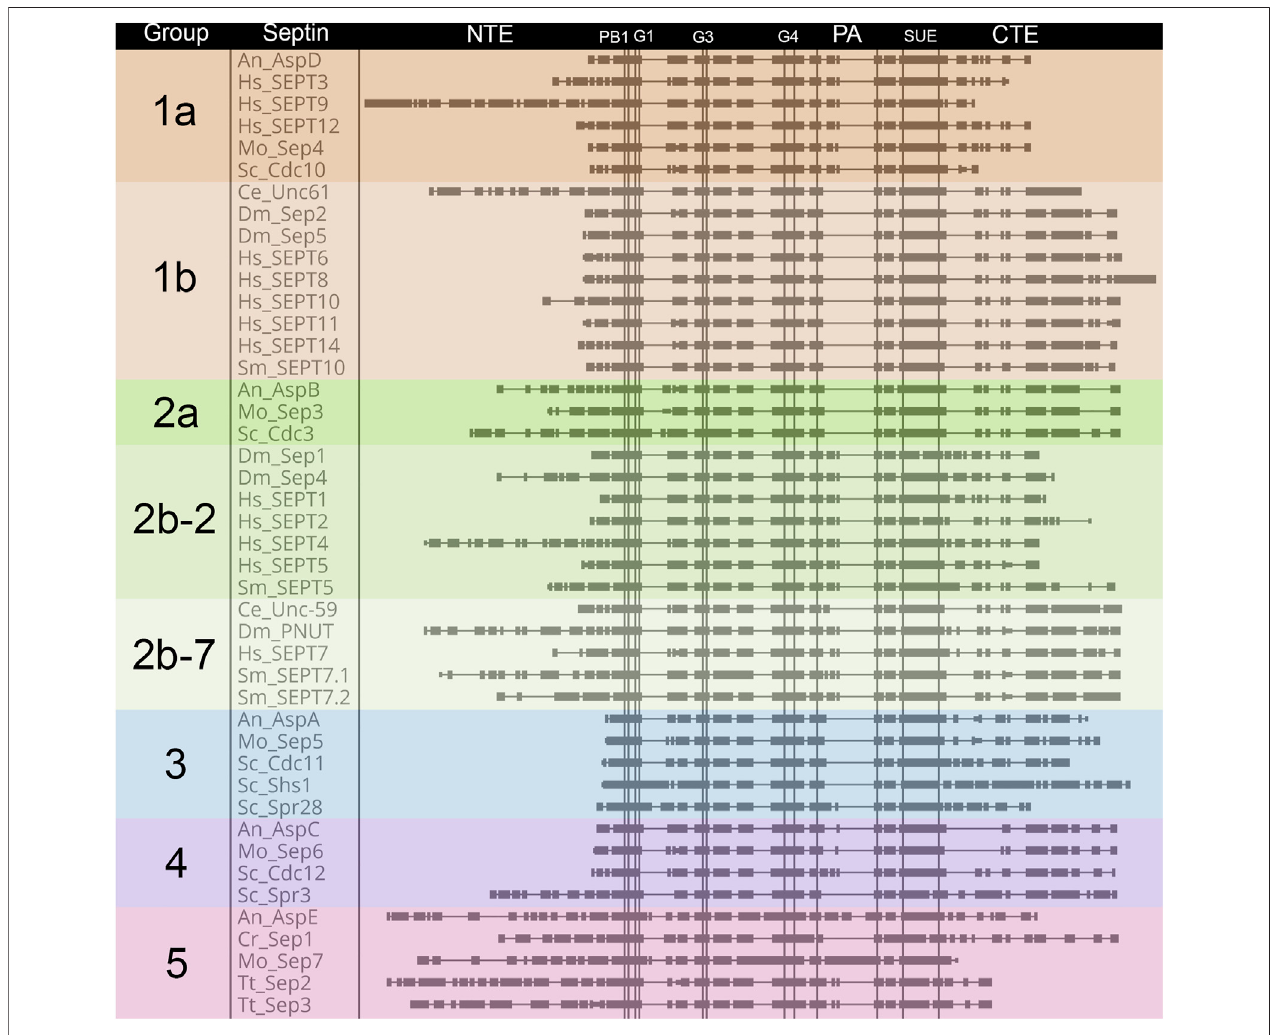
FIGURE 4 | Comparison of septin domain conservation. Large scale view of septins highlighting areas with variable sequence lengths. Septin proteins were aligned usingClustalOmega(Madeiraetal.,2019),andplacedinalphabeticalorderwithingroups.Domainsareasshownfor Figure2 andareindicatedabovethealignment.Vertical lines denote boundaries of domains. Rectangles indicate blocks of conservation. Thin horizontal lines indicate gaps introduced by Clustal to facilitate alignment.